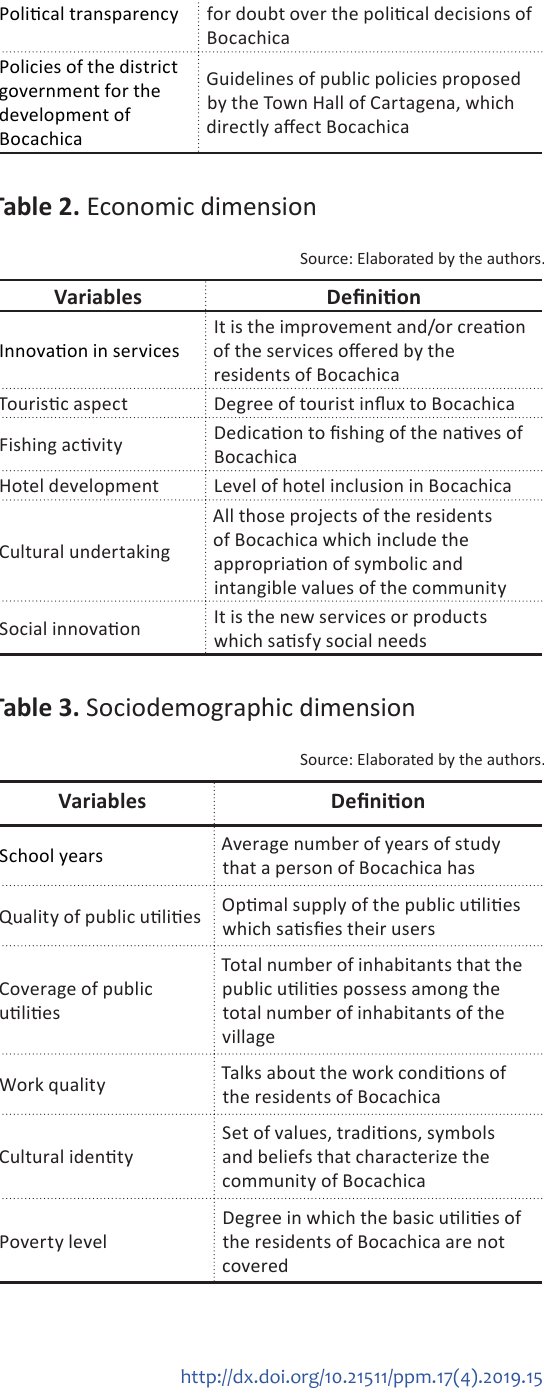
Table 1. Political dimension